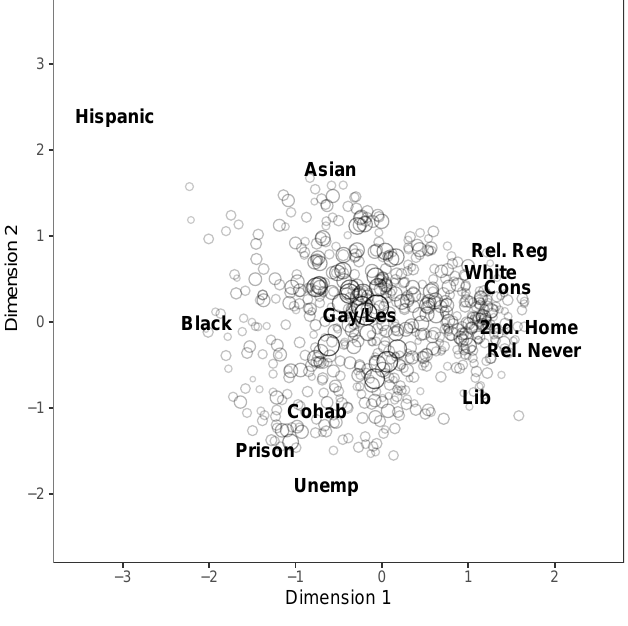
Figure 5: Distribution of respondents in social space, first two dimensions. Notes: (1) The first two dimensions account for 91.5 percent of the variance in the respondents’ posterior median positions. The corresponding number of the group position is 82.4 percent. (2) The sizes of the circles are proportional to the posterior median gregariousness ( γ i ) of the